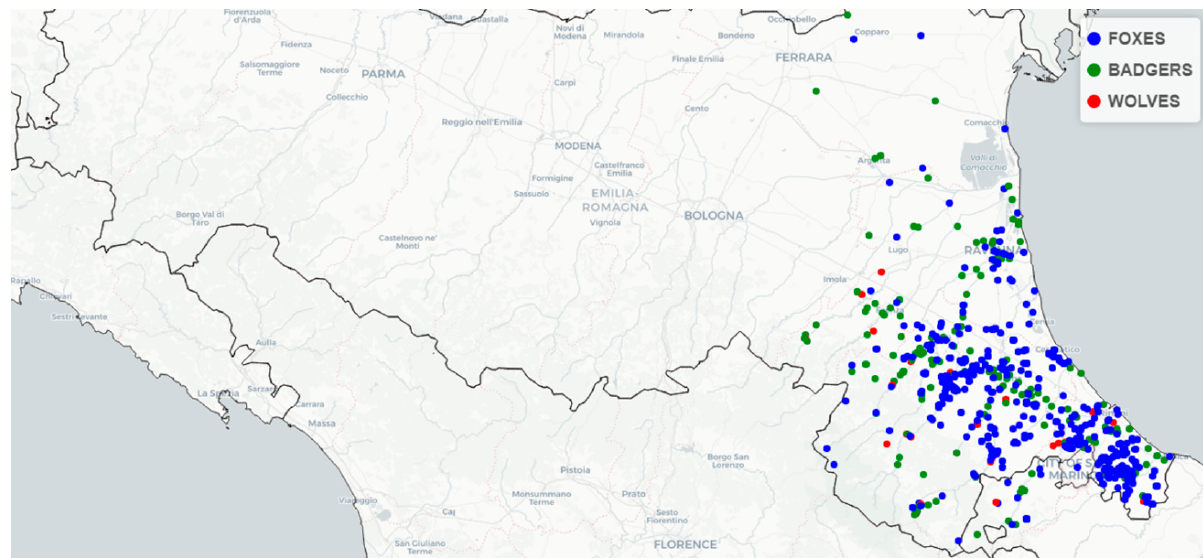
Figure 2. Spatial distribution of collected badger, fox and wolf carcasses (January 2016–September 2022).